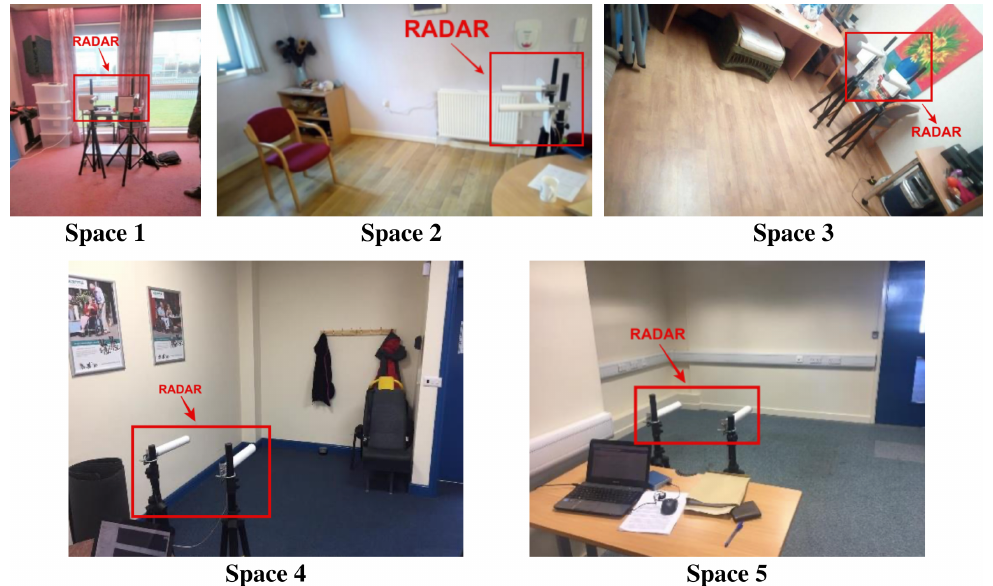
Figure 4. Diverse spaces used to acquire data on various human activities by employing participants of distinct ages [58].